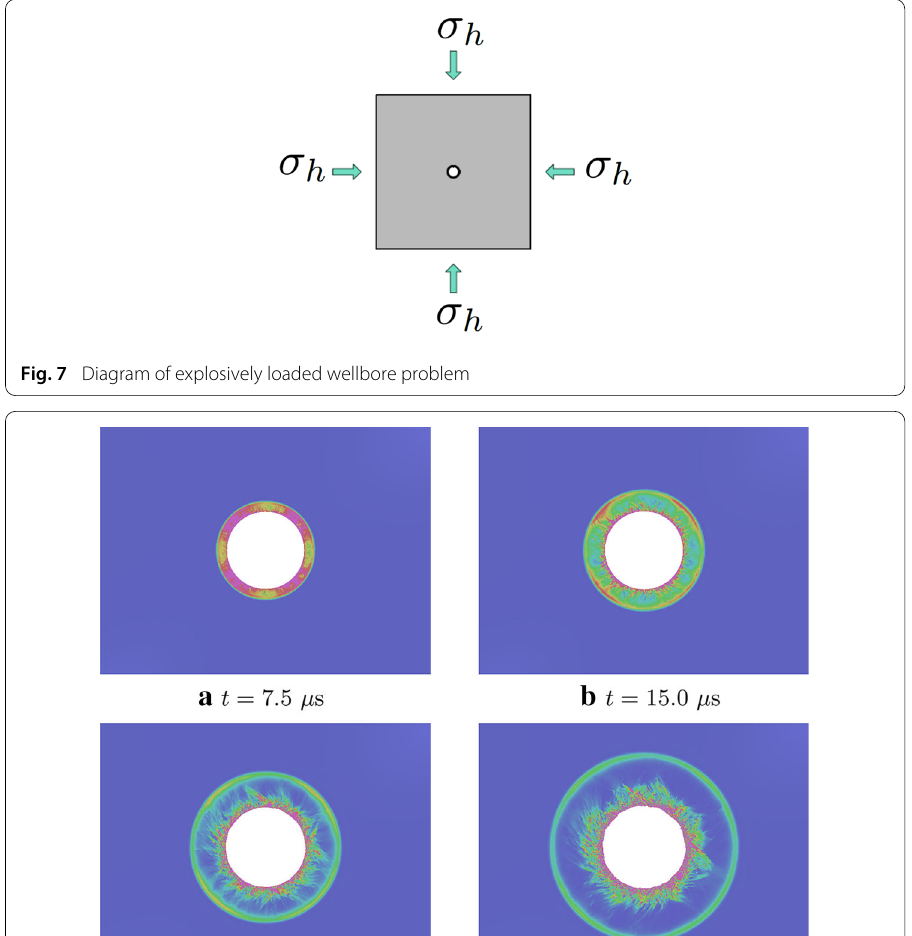
are ˜ τ = 30 μ s, β = 0, and k = 0 . 3. The displacement scale is ˜ δ = 8 . 05 μ m. We select contact regularization parameters, ¯ δ = 0 and δ = 805 nm, so that δ (cid:8) = 0 . 1. An explosive compressive pulse acts on the wellbore walls, ramping from ambient pressure to 27 . 5 MPa in 750 ns and then back to ambient